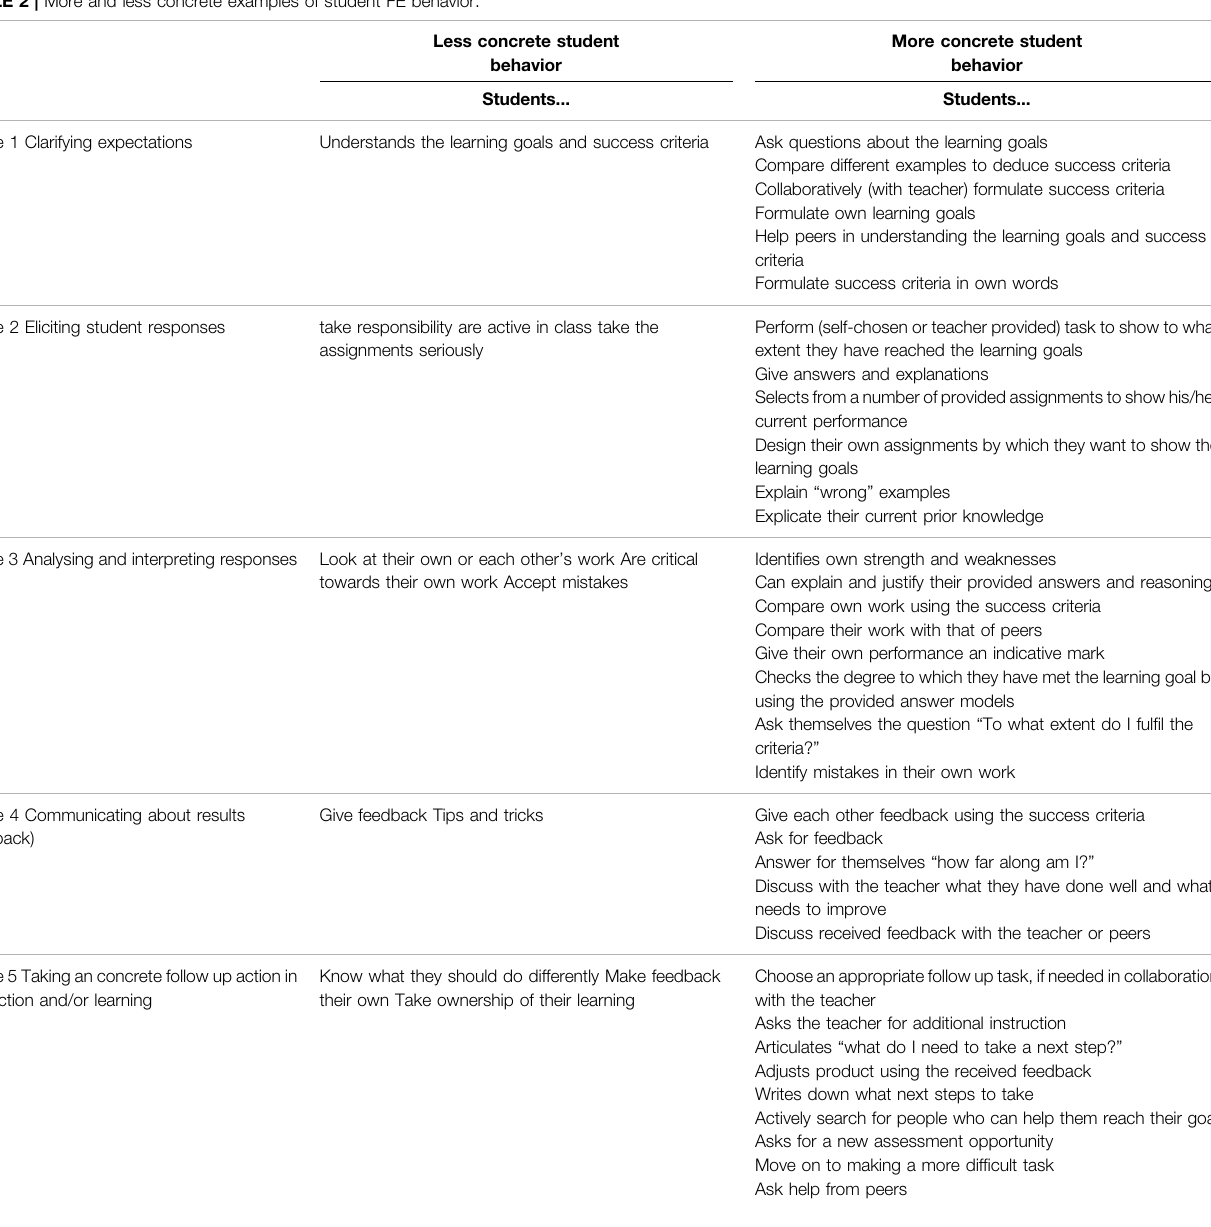
TABLE 2 | More and less concrete examples of student FE